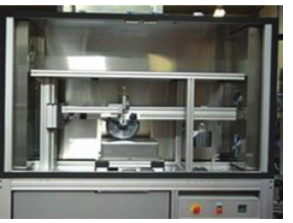
Fig. 2. Wheel tracking machine (after Cooper